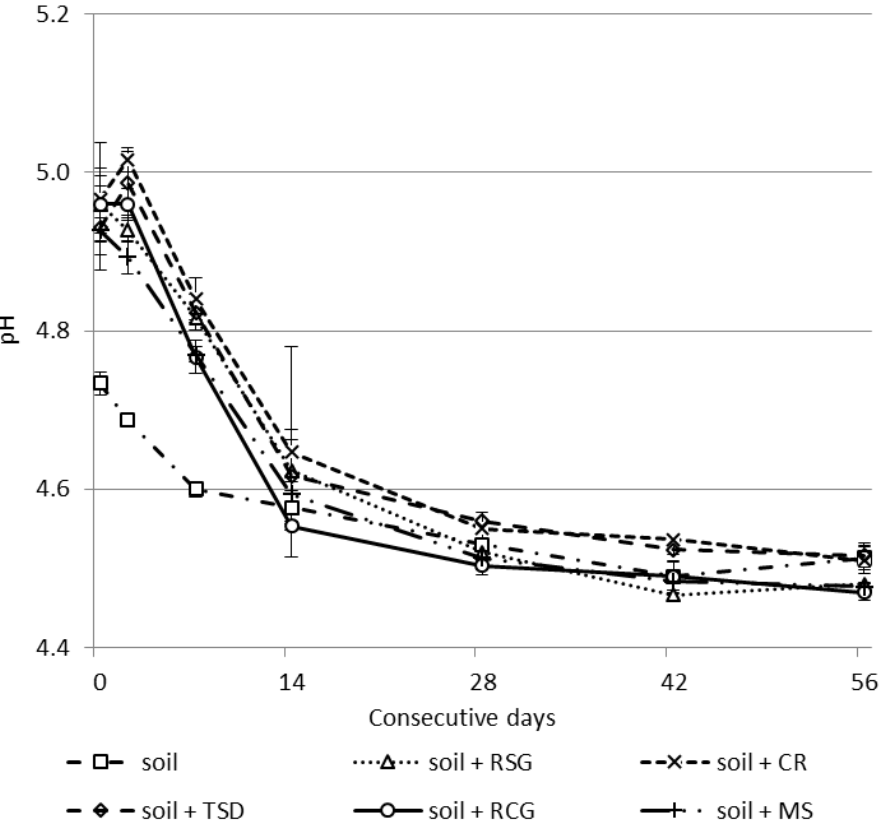
Figure 4. Soil pH dynamics (mean value ± standard deviation; where absent, bars fall within the symbols) during the incubation experiment, in the control (soil) and in soils treated with reed sweet-grass digestate (RSG), common reed digestate (CR), tufted sedge digestate (TSD), reed canary grass digestate (RCG) and maize digestate